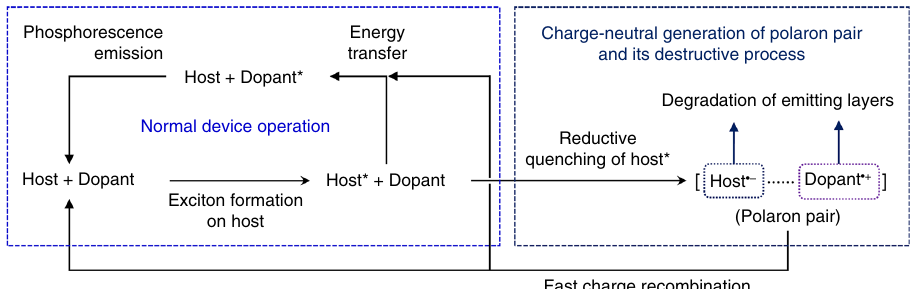
Fig. 1 Exciton-induced generation of polaron pairs. Electronic processes for the charge-neutral, exciton-mediated generation of radical ion pairs within an emitting layer consisting of a host and a dopant. Direct formation of a dopant exciton (e.g., dopant*) is not included, because intermolecular electron transfer between a host and a dopant exciton is usually forbidden due to negative driving